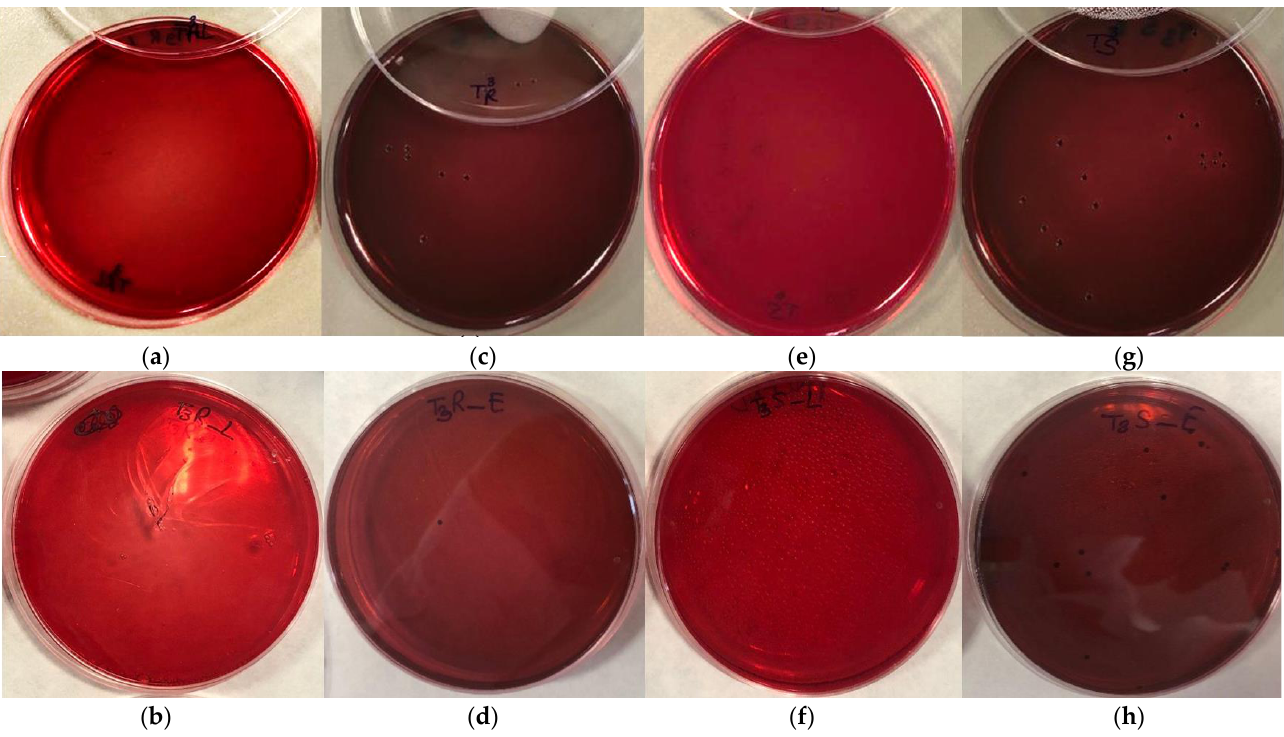
Figure 6. Antibacterial activity of ( a ) Additive R with Listeria monocytogenes at 0 h ( b ) Additive R with Listeria monocytogenes at 24 h ( c ) Additive R with E. coli at 0 h ( d ) Additive R with E. coli at 24 h ( e ) Additive S with Listeria monocytogenes at 0 h ( f ) Additive S with Listeria monocytogenes at 24 h ( g ) Additive S with E. coli at 0 h ( h ) Additive S with E. coli at 24 h.